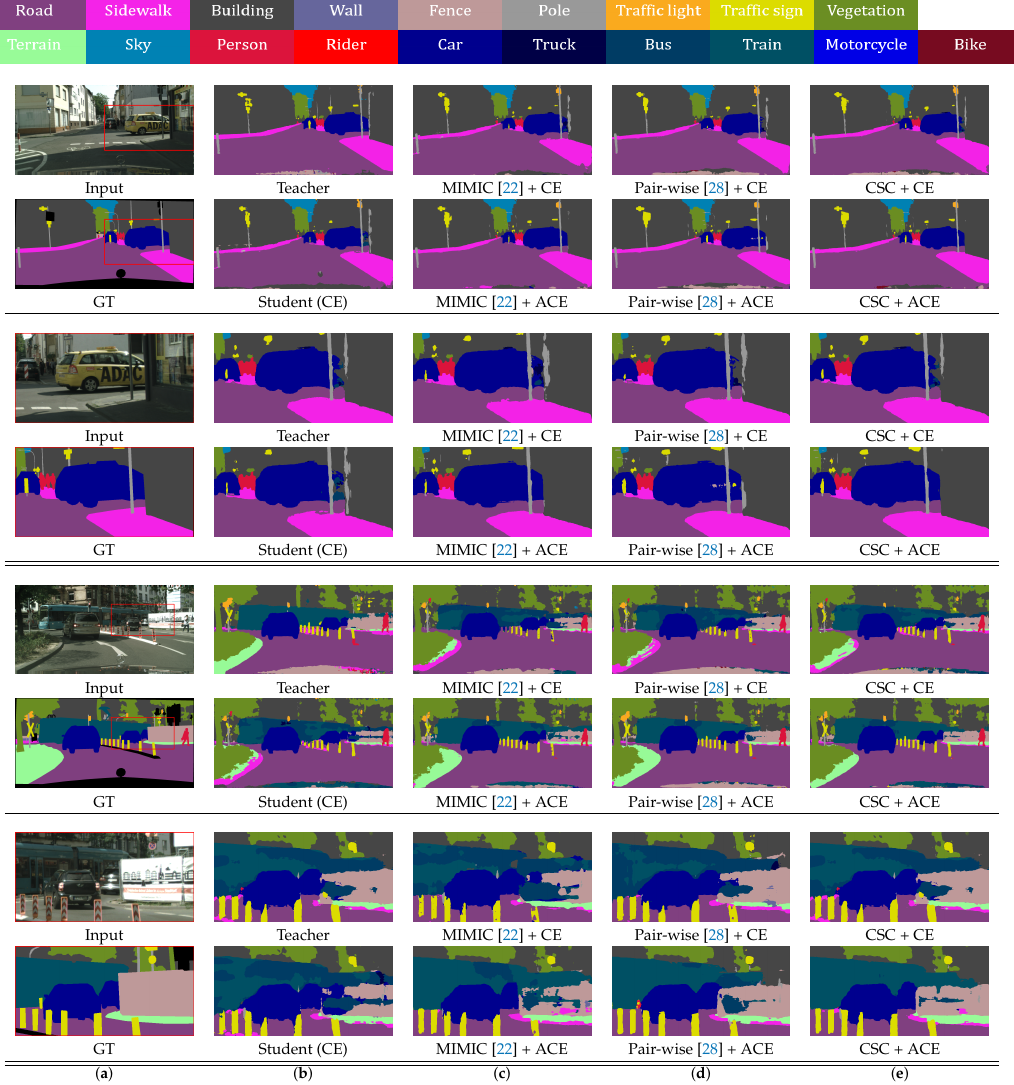
Figure 7. Qualitative comparison of various methods on the Cityscapes validation set. ( a ) Input and ground-truth (GT) images. ( b ) Teacher and student (CE) networks. ( c ) MIMIC [22]. ( d ) Pairwise [28]. ( e ) Proposed